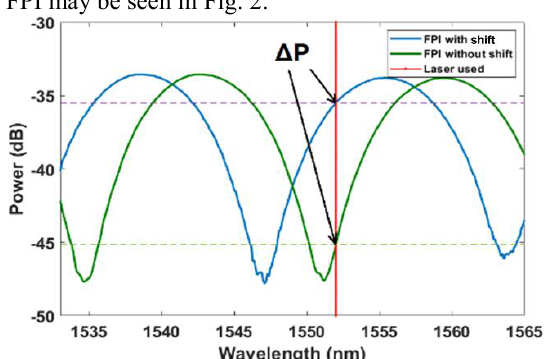
Fig. 2. Interference spectrum of the FPI cavity, showing the region where the laser operates and the correspondent power that can be filtered by the edge of the FPI, when the FPI is under strain.